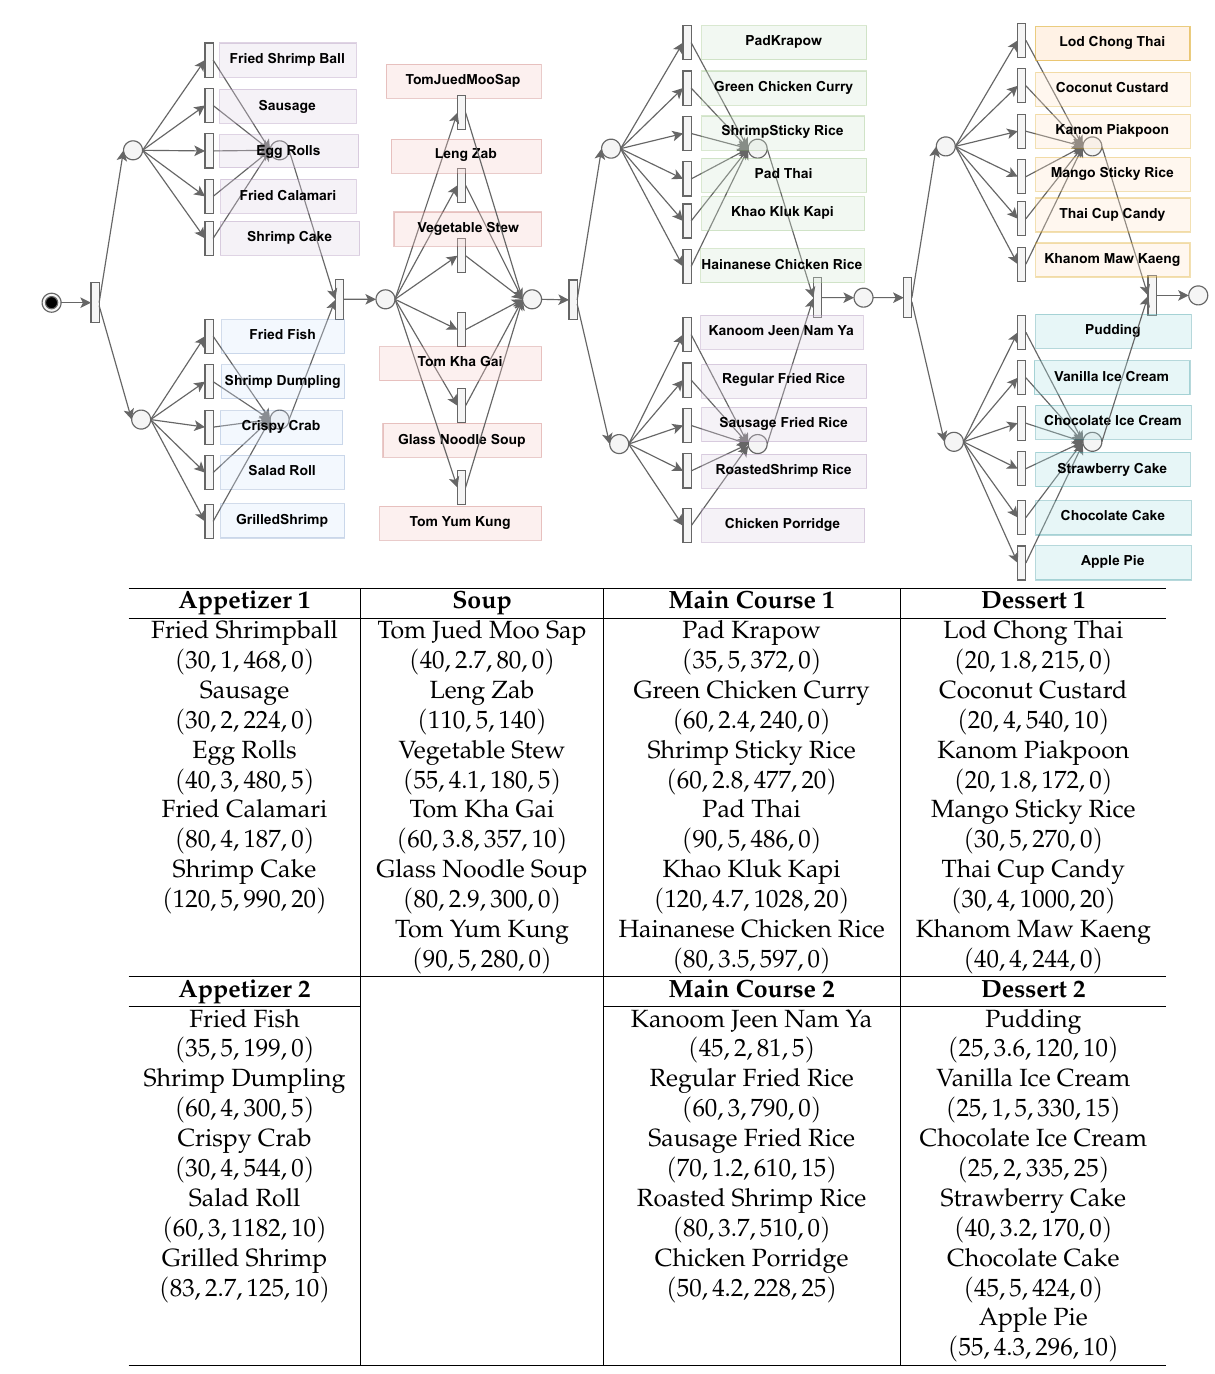
Figure 2. Menu of items with their attributes ( Price , Rating , Calorie , Discount )